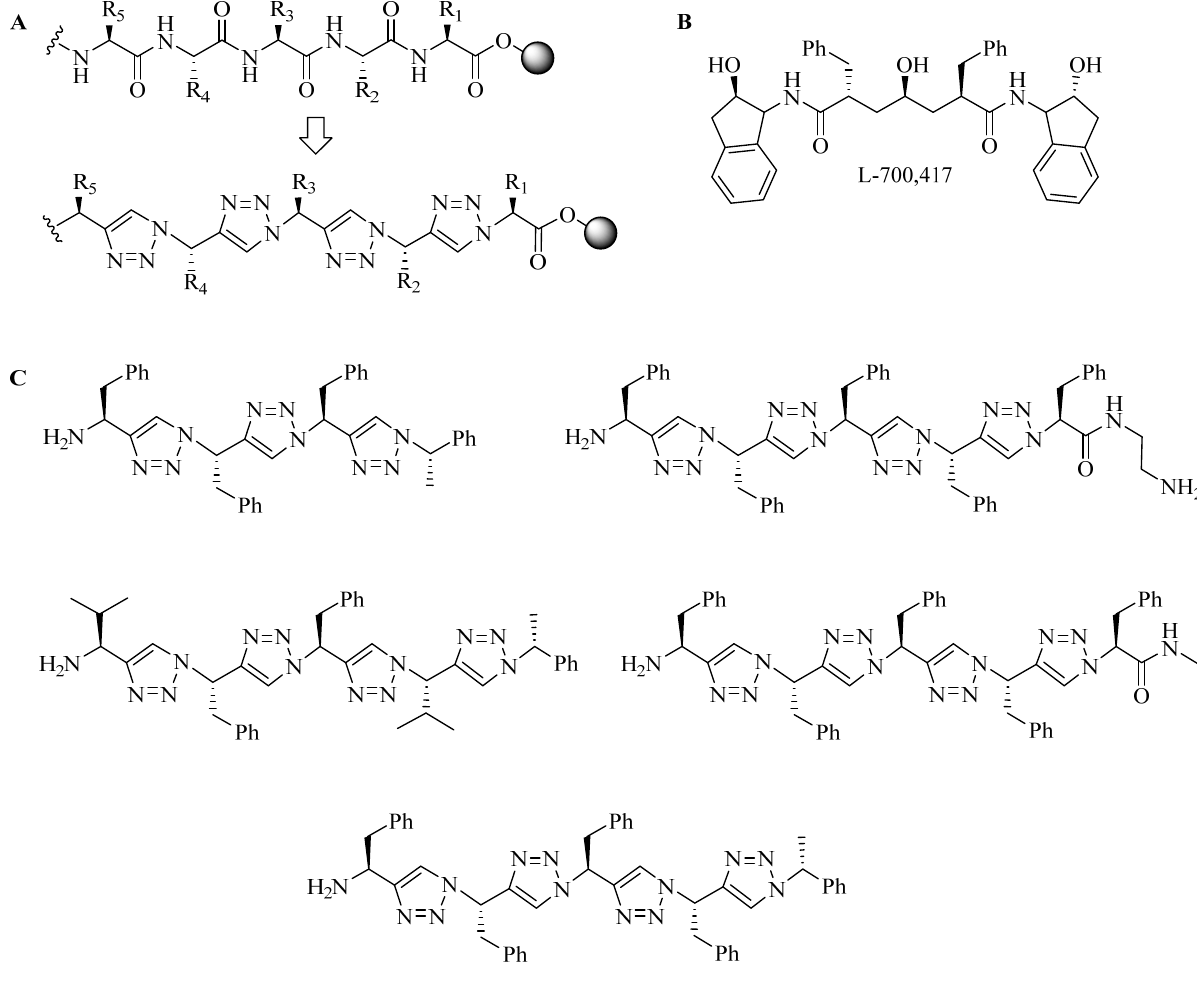
Figure 10. ( A ) Amide backbone modification with triazole rings; ( B ) HIVPR inhibitor; ( C ) Triazolamer-based HIVPR